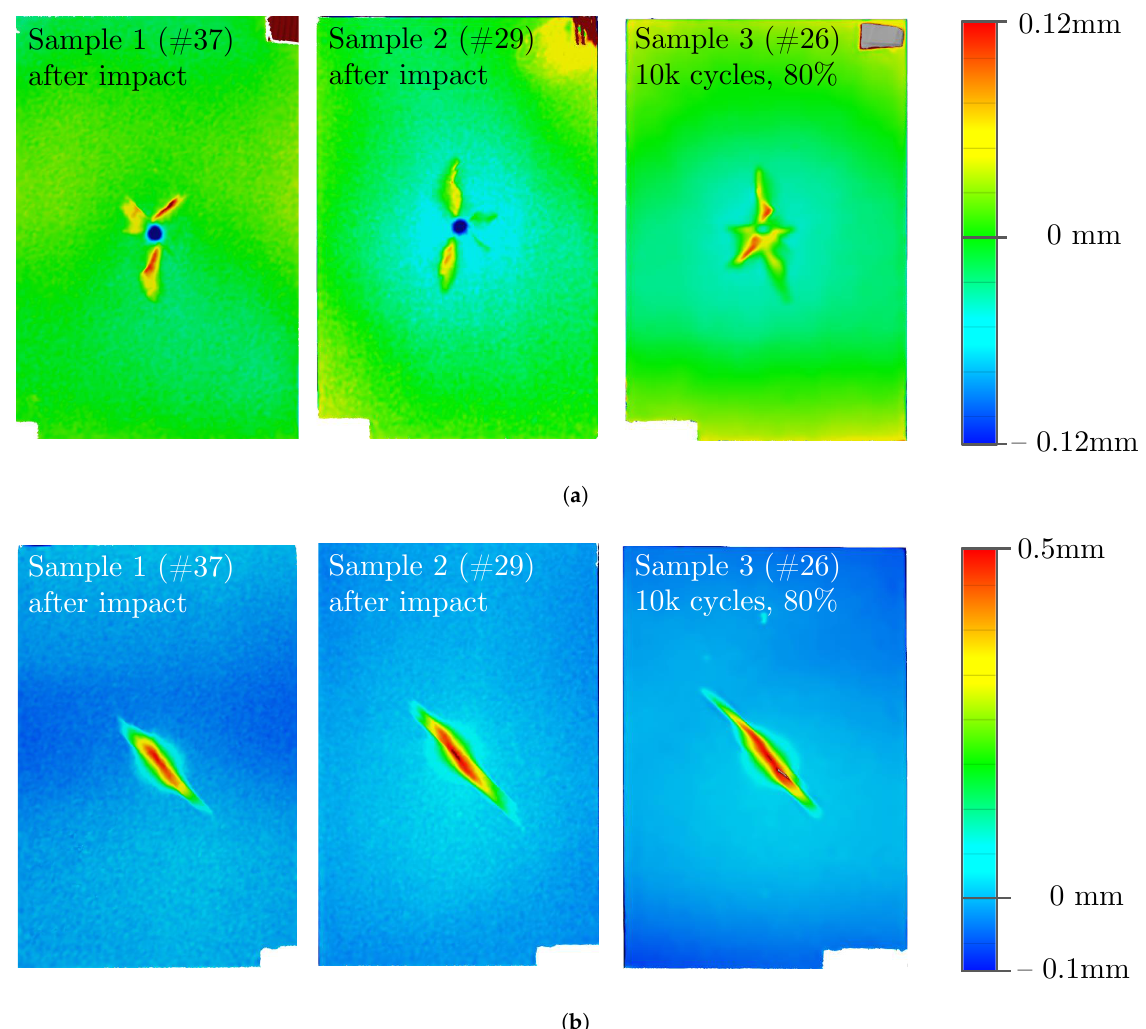
Figure 12. Surface geometry measured through 3D scanning directly after the impact (two specimens) and one specimen after the relaxation over 10k load cycles (one specimen). ( a ) Scans of the impact side, ( b ) Scans of the back